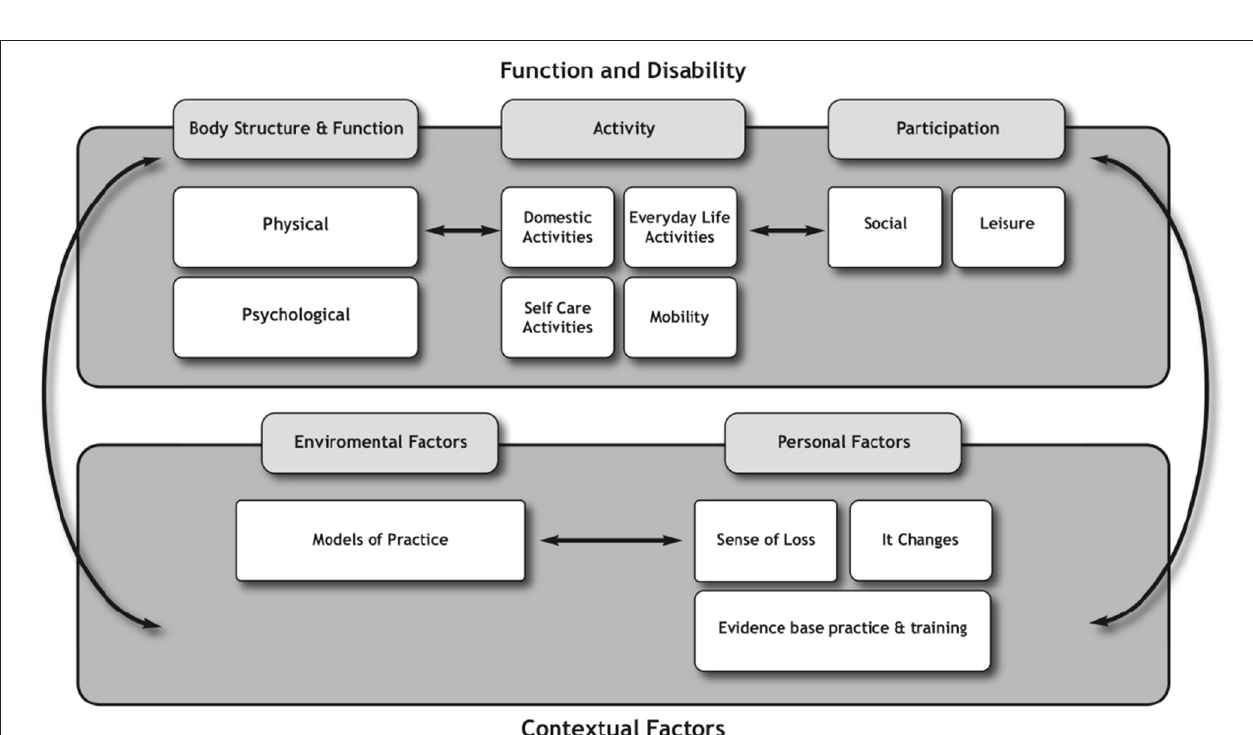
FIGURE 3 | Representation of the professional (physiotherapists) perspective in relation to the ICF.